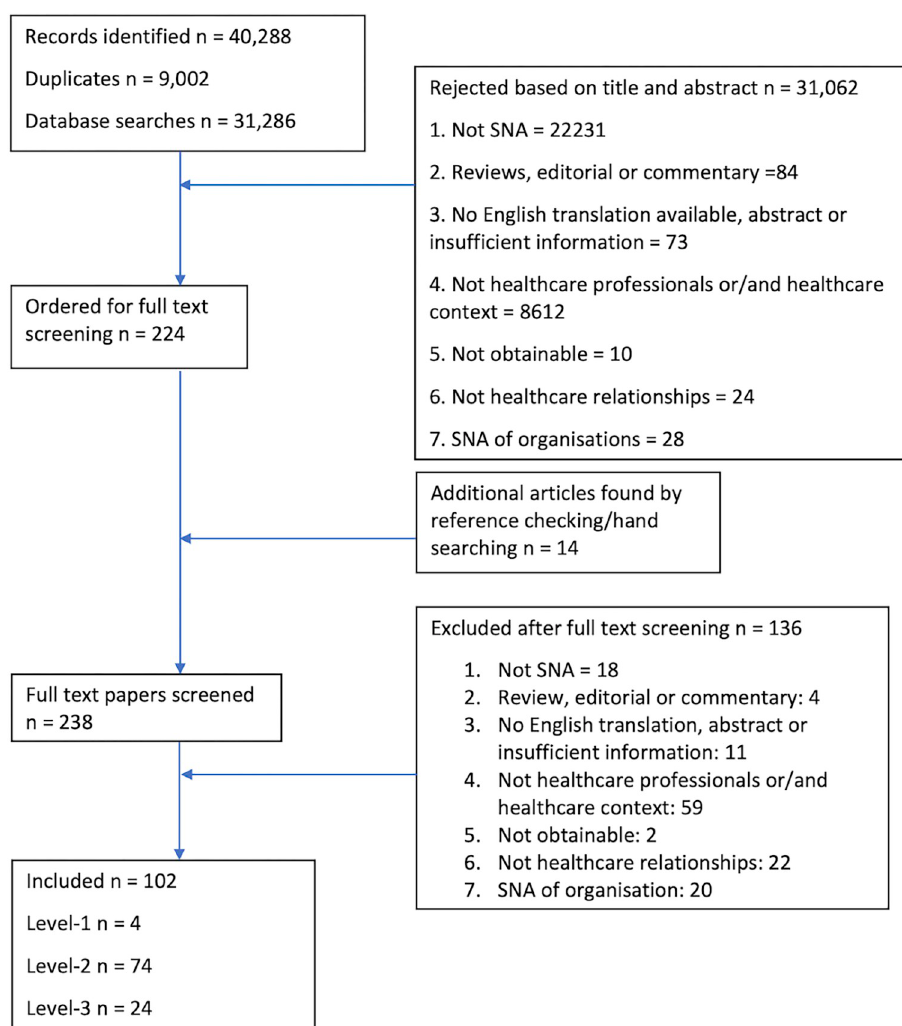
Fig 1. Flow diagram of study selection